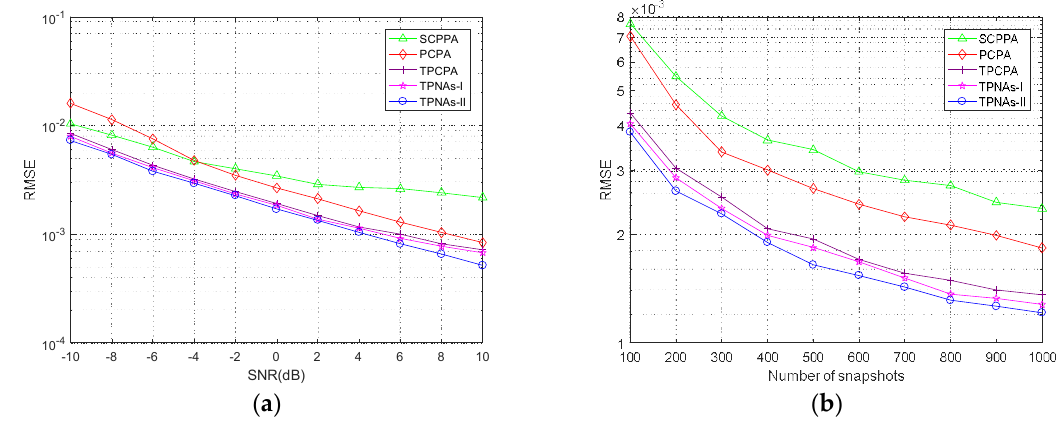
Figure 6. RMSE performance comparison with three signals. ( a ) As a function of SNR with T = 500, ( b ) as a function of snapshots with SNR = 0 dB.